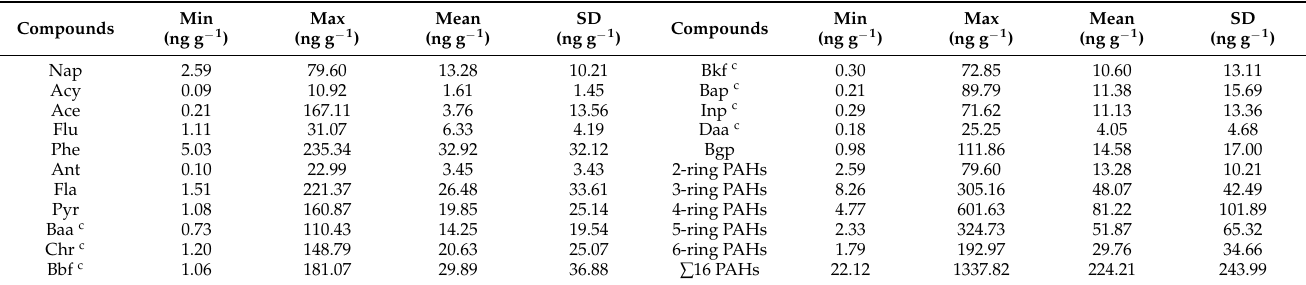
Table 1. Concentrations of polycyclic aromatic hydrocarbons (PAHs) in the soil samples from Shanxi Province (ng g − 1